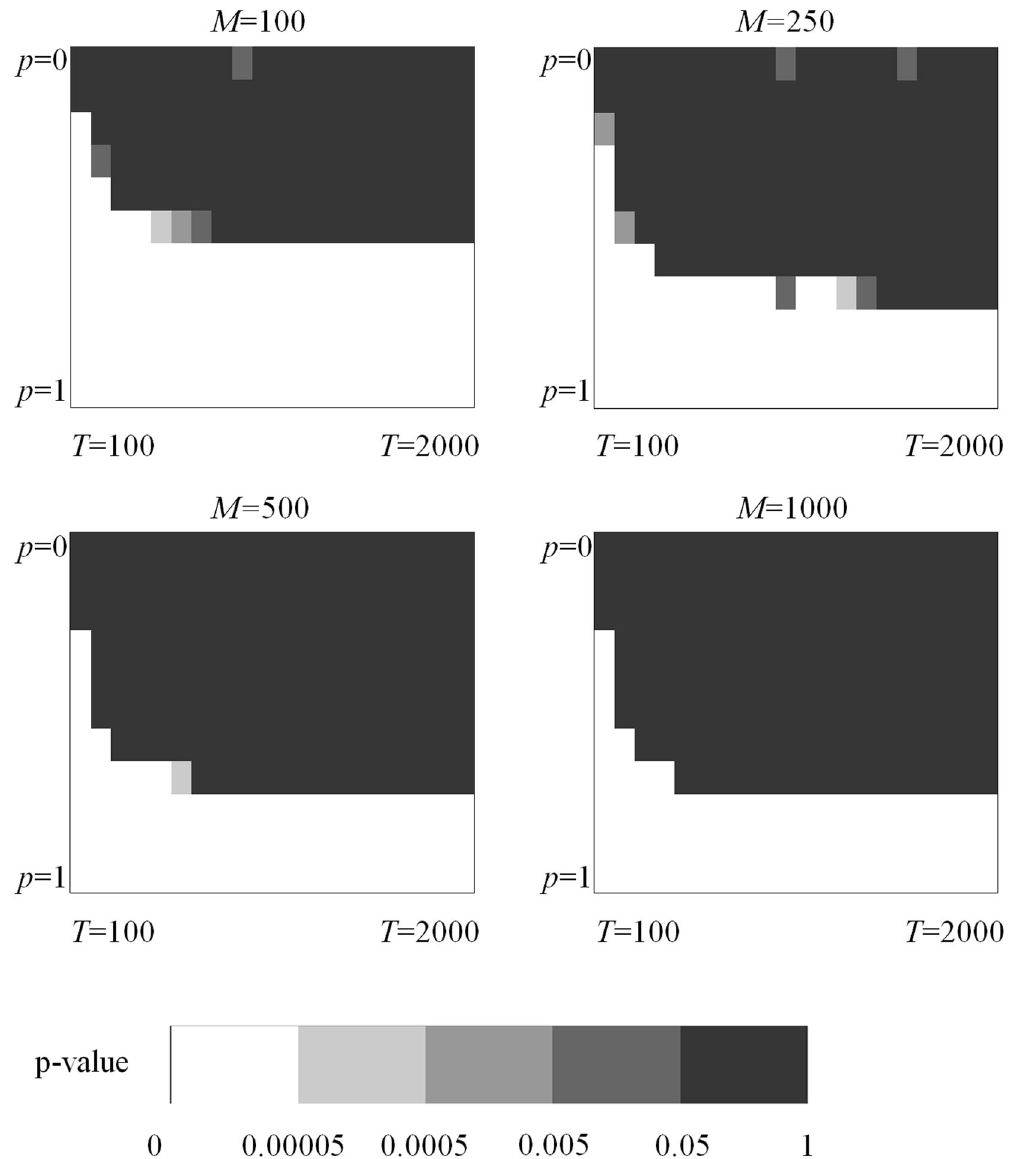
Fig. 7 The effect of the number of patches M on model behavior. Explanation of the fi gure is exactly the same as in Fig. 5. In general, more non-black squares appear as M decreases, implying solitary behavior is favored. Values for other parameters are: D = 0.002, N = 20, Q = 1, S = 1, E =